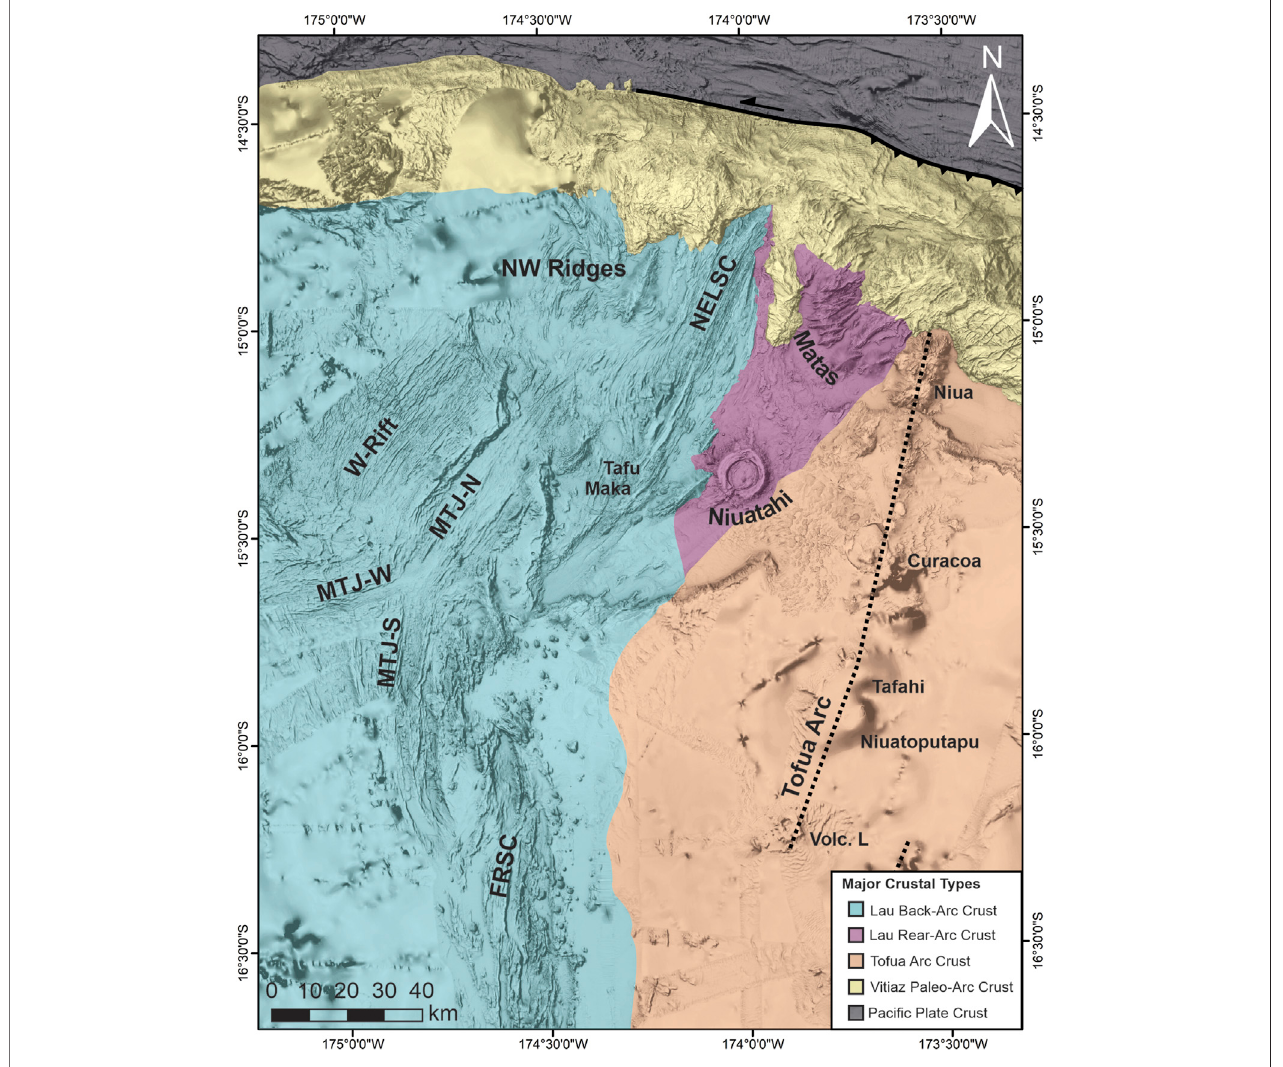
FIGURE 4 | Crustal types in the study area overlain on a compilation of ship multibeam bathymetry (compilation data as in Figure 3 ), described in detail in Supplementary Table S1 . Note that the contacts between crustal types are approximate. “ Matas ” refers to the Mata volcanos; other abbreviations as in Figure 2 .